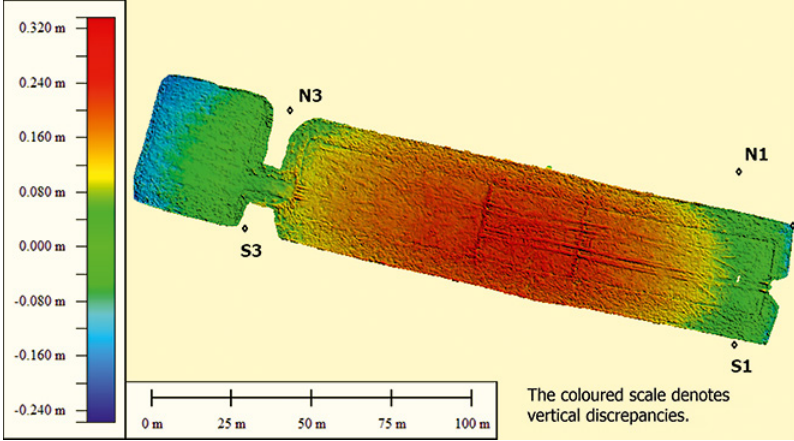
Figure 8. comparison of the unmanned aerial vehicle surface models calculated with all the ground control points and only four ground control points (S1, S3, N1,